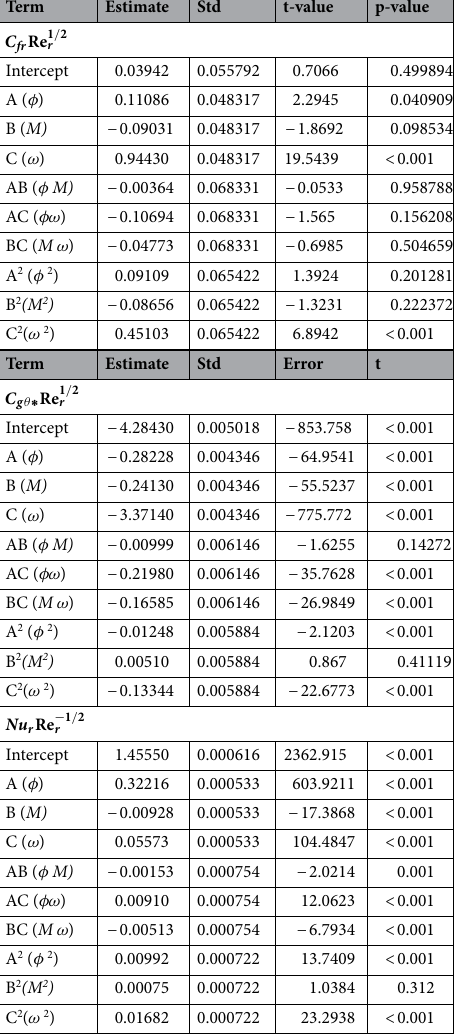
Table 7. Fitted model terms estimates mates together with t-values and p-value is presented.